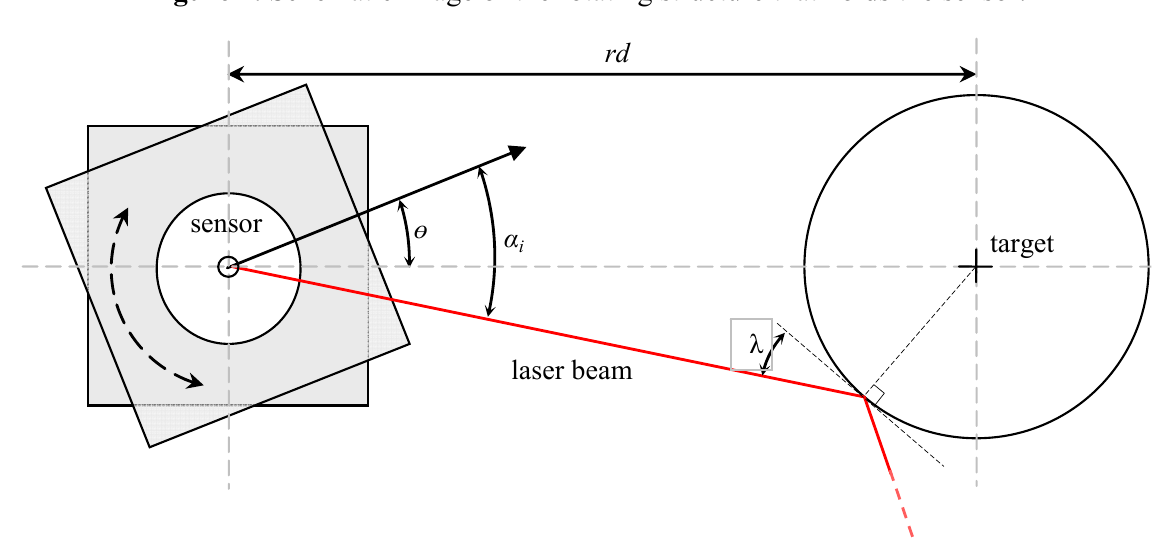
Figure 4. Schematic image of the rotating structure that holds the sensor.